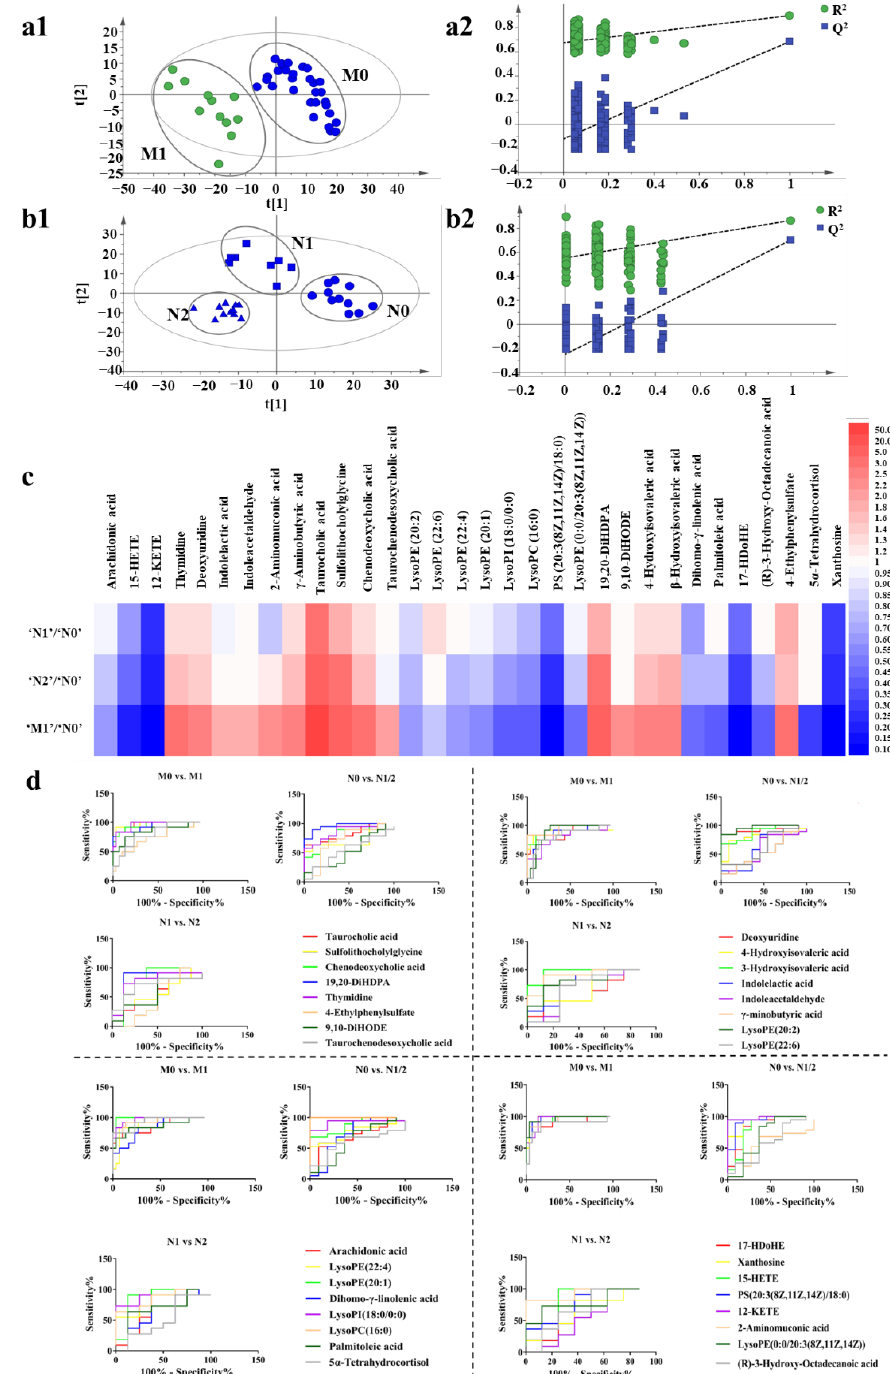
Figure 3. Metabolic profiling analysis among ‘N0’, ‘N1’, ‘N2’, and ‘M1’ groups. ( a1 ) The score plot for PLS-DA to discriminate ‘M0’ ( n = 30) and ‘M1’ ( n = 12). ( a2 ) Validation plot of the ‘M0’ and ‘M1’ groups that were obtained from 200 permutation tests. ( b1 ) The score plot for PLS-DA to discriminate ‘N0’ ( n = 11), ‘N1’ ( n = 8), and ‘N2’ ( n = 11). ( b2 ) Validation plot of the ‘N0’, ‘N1’, and ‘N2’ groups